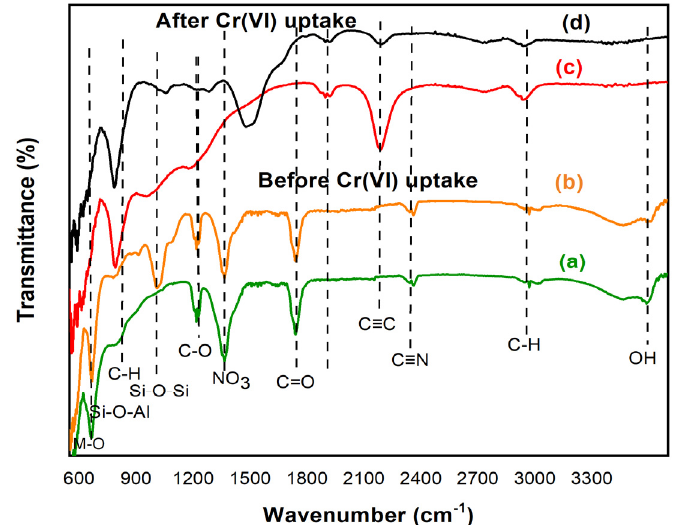
Figure 3. FTIR of CoAl-LDH before Cr(VI) uptake (a); bentonite-CoAl-LDH before Cr(VI) uptake (b); CoAl-LDH after Cr(VI) uptake (c); bentonite-CoAl-LDH after Cr(VI) uptake (d) under optimal conditions of temperature = 25 °C, pH 2 and 126 mg/L initial Cr(VI) concentration. Table 3. EDS elemental analysis for raw bentonite and the adsorbents